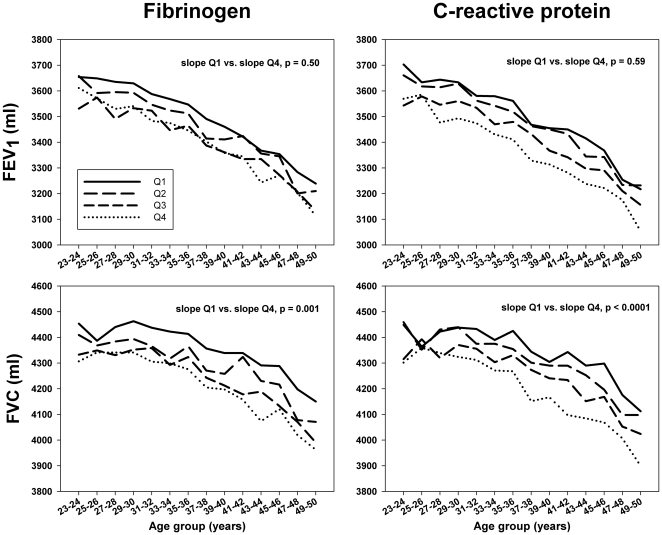
Relationship between age, lung function and quartile of fibrinogen or CRP (measured at year 7).Spirometry exams performed at CARDIA visits at years 5, 10, and 20 were used to determine a mean lung function for each 2 year age group across year 7 CRP or fibrinogen quartiles, and slopes compared between the highest and lowest quartile groups. For both fibrinogen and CRP, the age-related decline in FVC was significantly different between quartiles 1 and 4. There were no significant differences in the FEV1 across CRP or fibrinogen quartiles.Covariates in the model include race-sex group, exam year, pack-years of cigarette exposure, and time-dependent age, time-dependent height and height-squared, and year 5 waist circumference and time-dependent change in waist circumference.